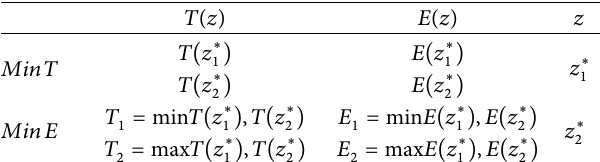
Table 1: Payoff table of positive-ideal solution.